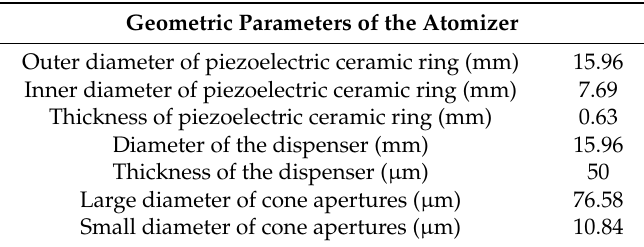
Table 1. Geometric parameters of the